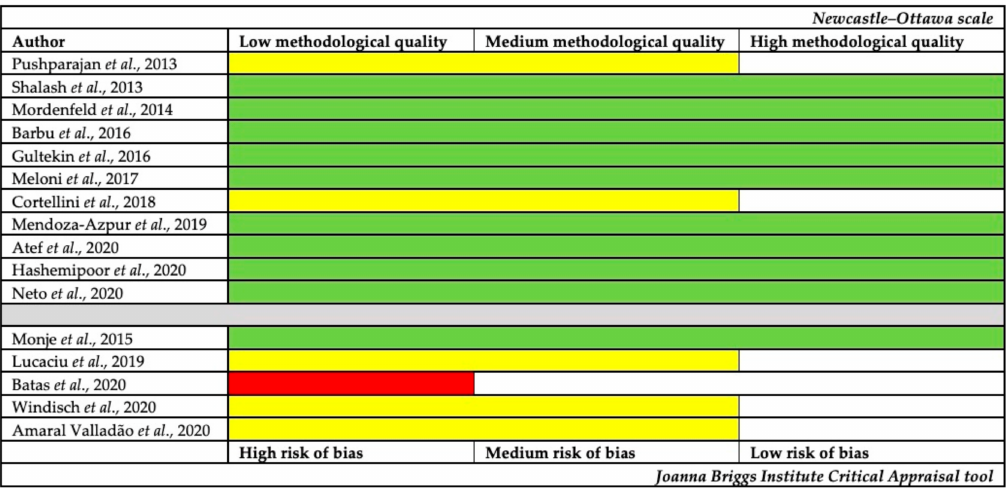
Figure 2. Studies’ quality assessment and risk of bias following: Newcastle–Ottawa scale for interventional and observa- tional assays. Studies were considered as having a high (green), medium (yellow), or low (red) methodological quality, and the Joanna Briggs Institute Critical Appraisal tool for case series. Studies were considered as having high (red), moderate (yellow), or low (green) risk of bias.